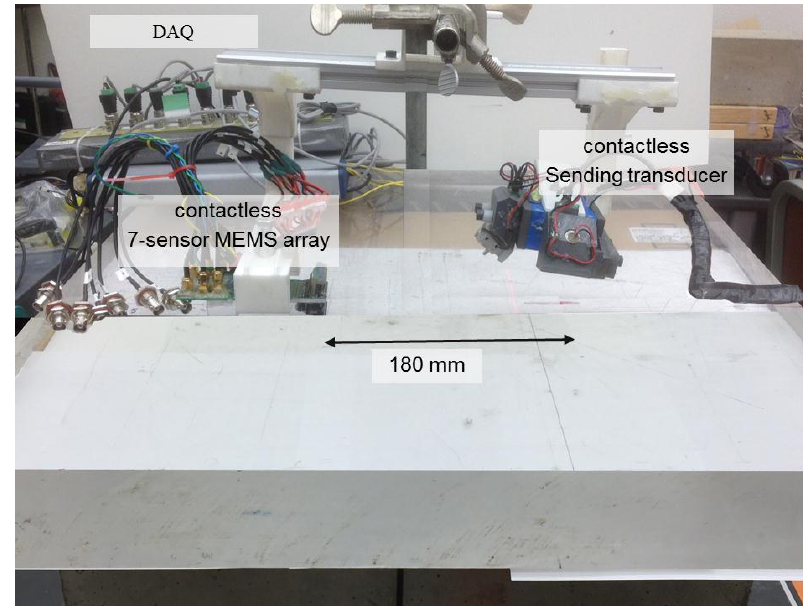
Figure 6. Ultrasonic surface wave testing configuration on the Poly-methyl methacrylate (PMMA) sample; 7-sensor MEMS array used to receive